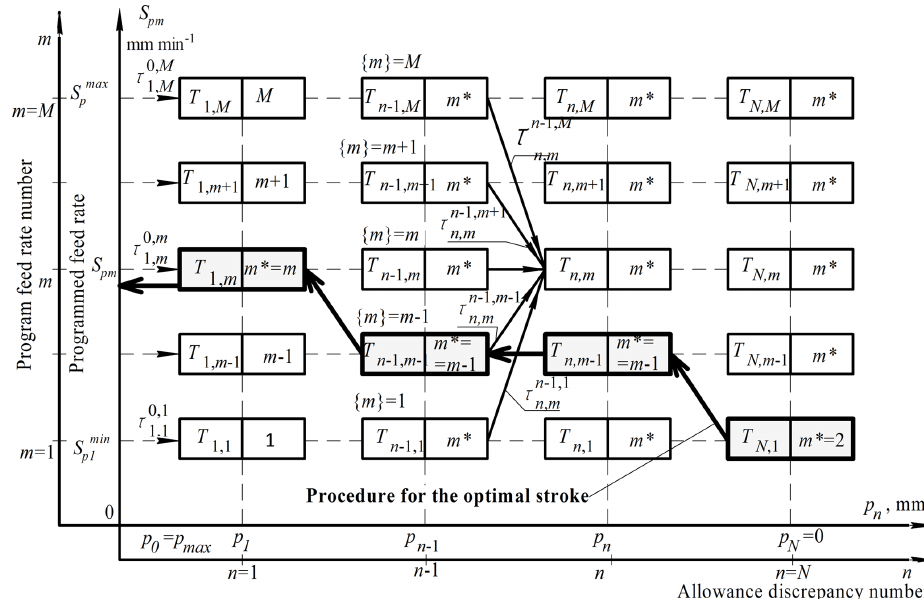
Figure 3. Grid for optimizing the grinding cycle ( S pm – nominal program minute feed in the DPM optimization system, mmmin − 1 ).